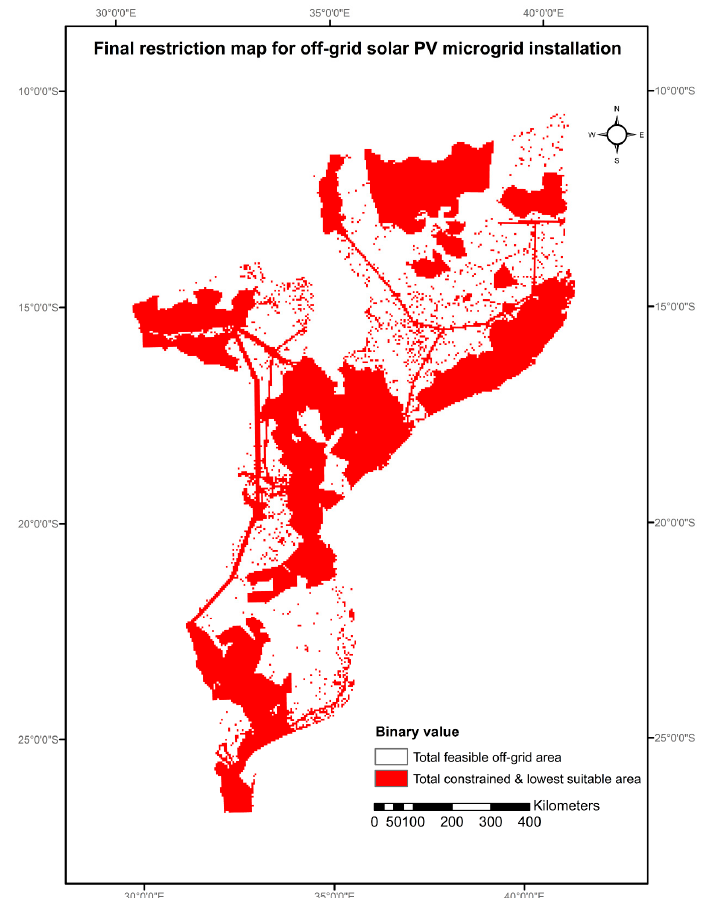
Figure 6. The final map of constrained and lowest suitability areas for off-grid solar PV microgrid sites in Mozambique.